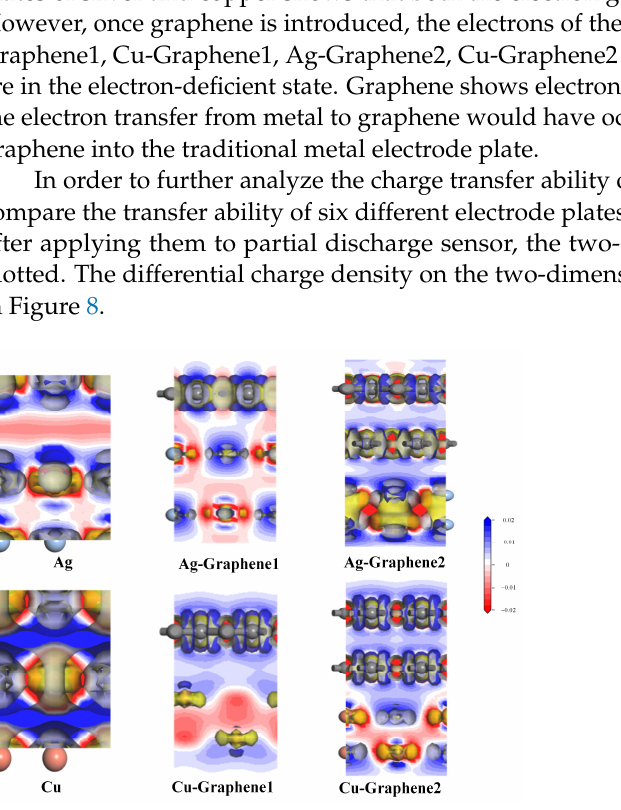
Figure 8. The two-dimensional differential charge density interface of different electrode plates.